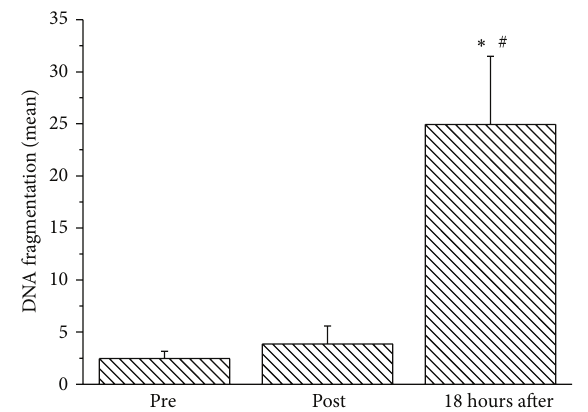
Figure 3: ROS release by neutrophils in ballet dancers was deter- mined before, immediately after, and 18 hours after a ballet class. The measurements were performed under basal and PMA-stimulated conditions. The values are presented as the means ± standard errors of 13